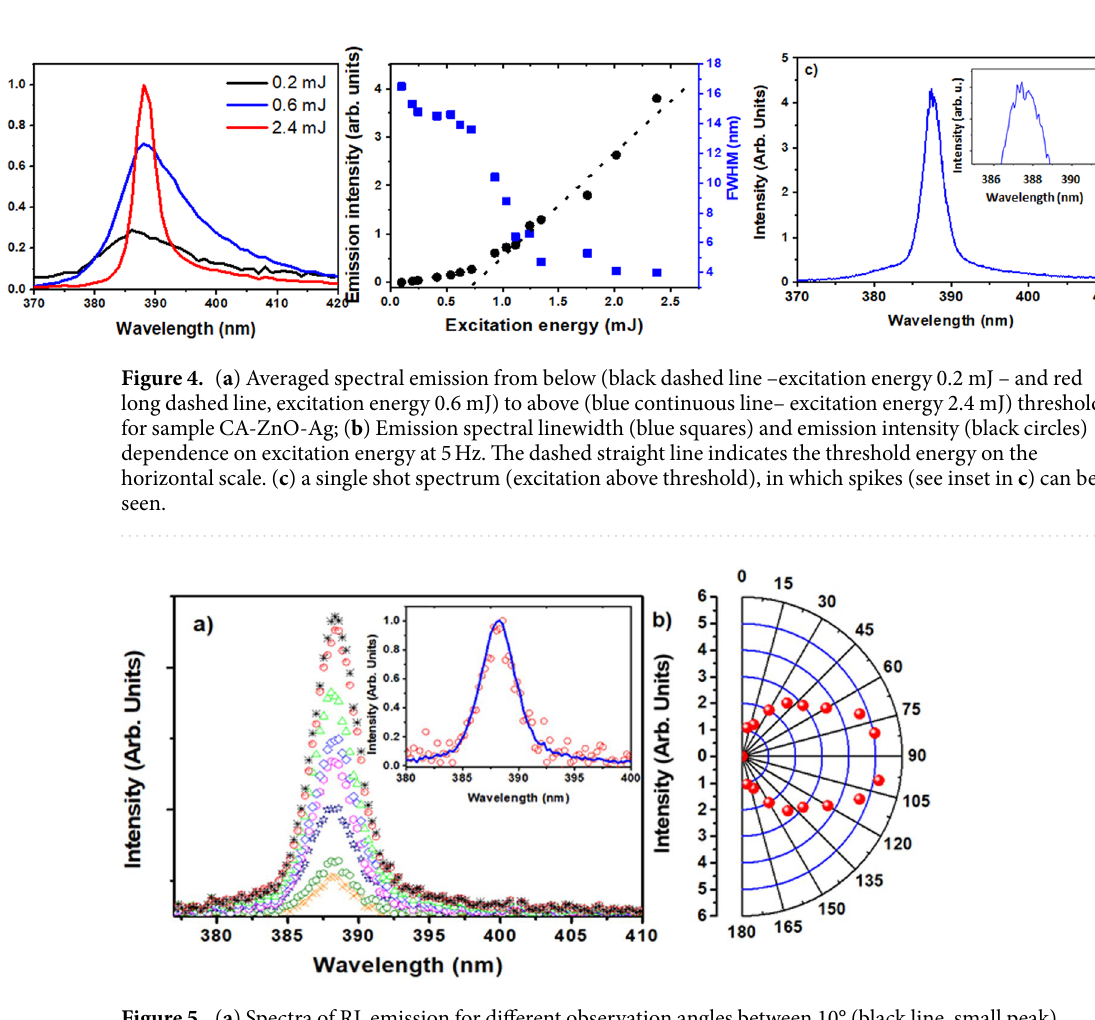
Figure 5. ( a ) Spectra of RL emission for different observation angles between 10° (black line, small peak) and 80° (brown line, large peak) with 10° intervals with respect to the sample surface. The inset shows the normalized RL intensity at 10° (red open circles) and 80° (blue line); ( b ) angular dependence of the RL peak intensity in the range 10°–170°. Sample: